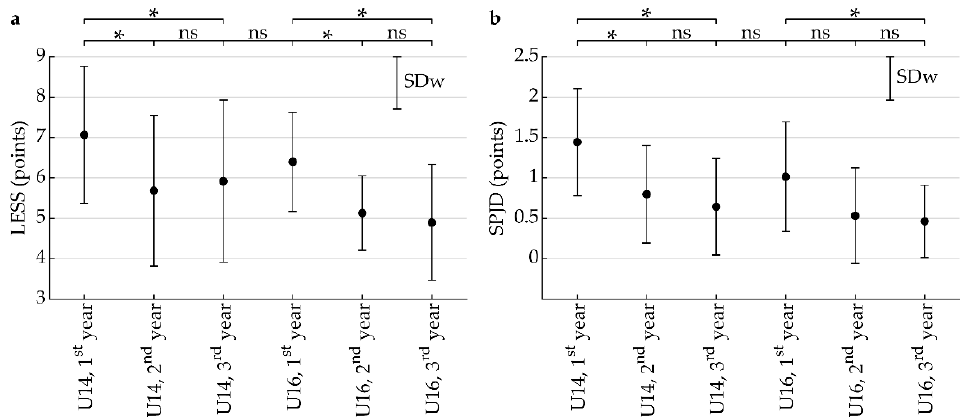
Figure 1. Age-related changes in landing error scoring system ( a ) and sagittal plane joint displace- ment ( b ). Values are presented as arithmetic means and standard deviations. Only within-group pairwise comparisons are displayed. LESS—landing error scoring system; SPJD—sagittal plane joint displacement; SDw—within-subject standard deviation; *—statistically significant ( p < 0.05, Fisher’s post hoc test); ns—not significant.